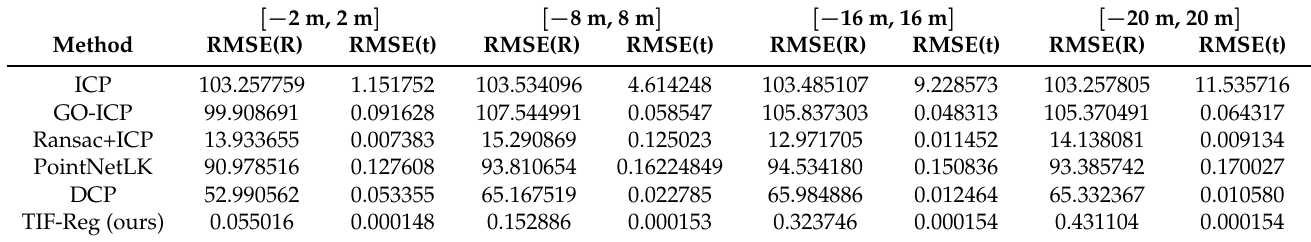
Table 4. Testing translation robustness with rotation within [ − 180 ◦ , 180 ◦ ] . [ − 2 m, 2 m